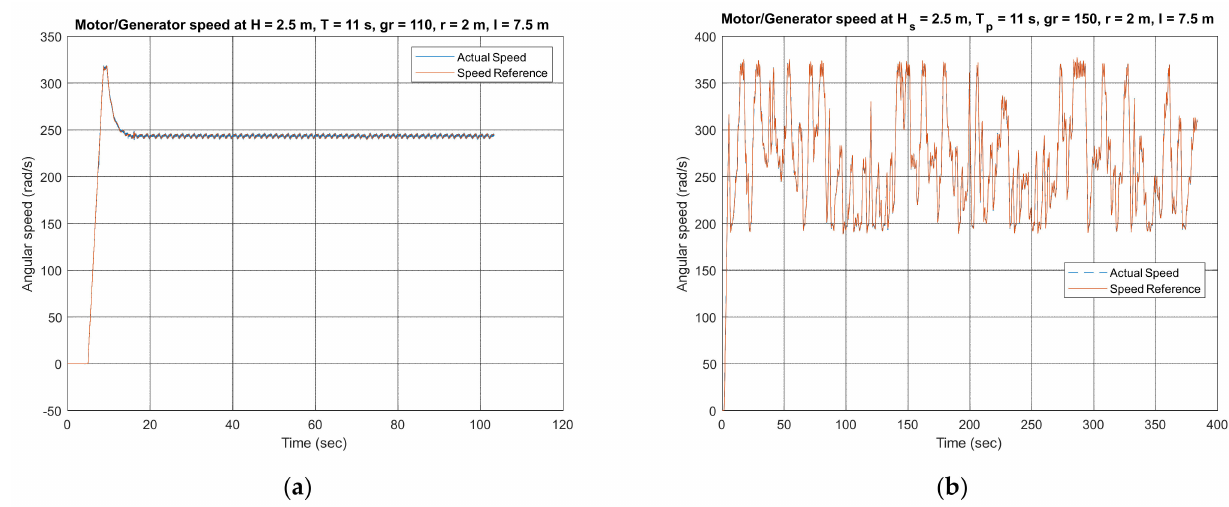
Figure 7. Continuous unidirectional rotation in experimental test with ( a ) regular waves and ( b ) irregular waves. The armature currents drawn by the motor/generator pair (for the regular wave case in Figure 7a) are shown in Figure 8. Both the motor and generator hit their current limits of 8.5 A and − 7 A, respectively, because of the relatively low value of the gear ratio. The jitter envelope in the current profiles is switching and measurement noise- related. Increased current fluctuations and lower speed due to a smaller gear ratio caused problems, which substantially contributed to lower mean power and increased the PTAP ratio throughout the tests. Figure 9 clearly highlights that bringing down the crank radius to 1.5 m effectively reduces the peak-to-peak current fluctuations and, therefore, improves both the mean power and PTAP ratio. However, reducing the crank radius is likely to cause diminishing returns at a certain point, which are detailed in upcoming paragraphs. The instantaneous power curves corresponding to the operational cases in Figures 8 and 9 are shown in Figures 10 and 11, respectively. Power drawn (the motor case) translates to positive power, and power produced (the generator case) translates to negative power.